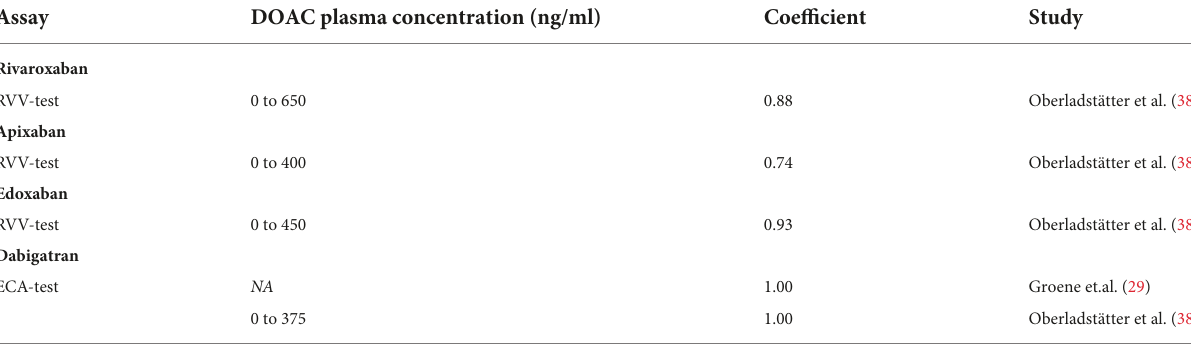
TABLE 2.3 Correlation of DOAC plasma concentration and ClotPro clotting time (CT) for different assays. Assay DOAC plasma concentration